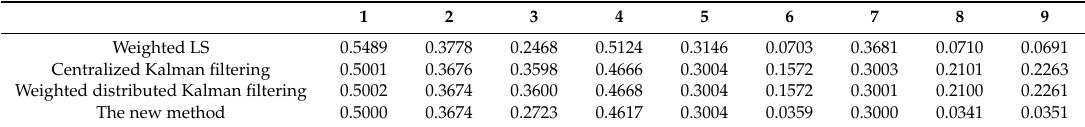
Table 9. The performance comparison among di ff erent